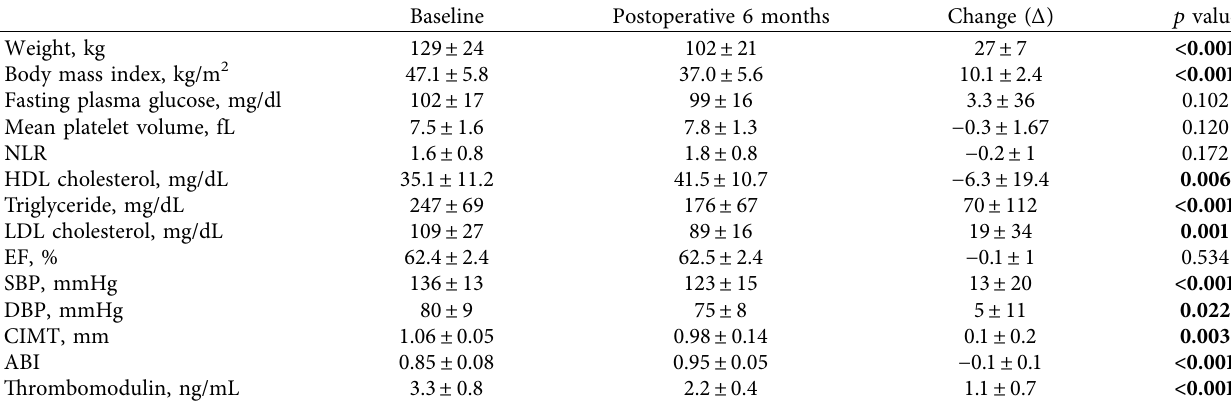
Table 2: The comparison of the clinical, laboratory, and echocardiographic parameters from baseline to the postoperative 6 months. Baseline Fasting plasma glucose, mg/dl